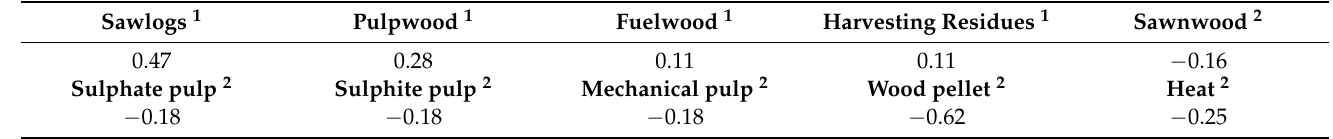
Table A6. Supply and demand